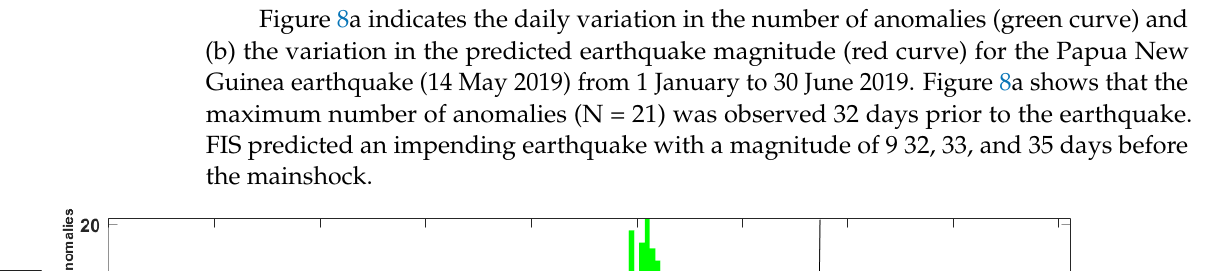
Figure 7. ( a ) Variation in the number of anomalies (green curve), ( b ) variation in the predicted earth- quake magnitude (red curve), and ( c ) variation in the observed earthquake magnitude (blue curve) for the Iran earthquake (12 November 2017) from 1 August to 30 November 2017. In both panels, the x -axis represents the day relative to the earthquake day, indicated as a vertical dotted line.